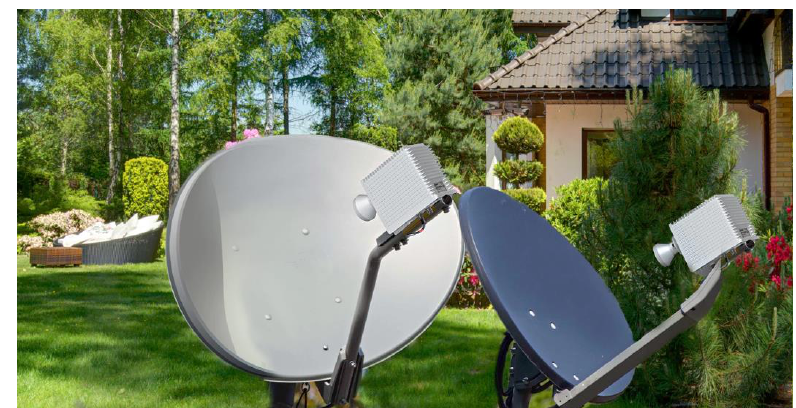
Figure 2. Smart low-noise block converter (SmartLNB).